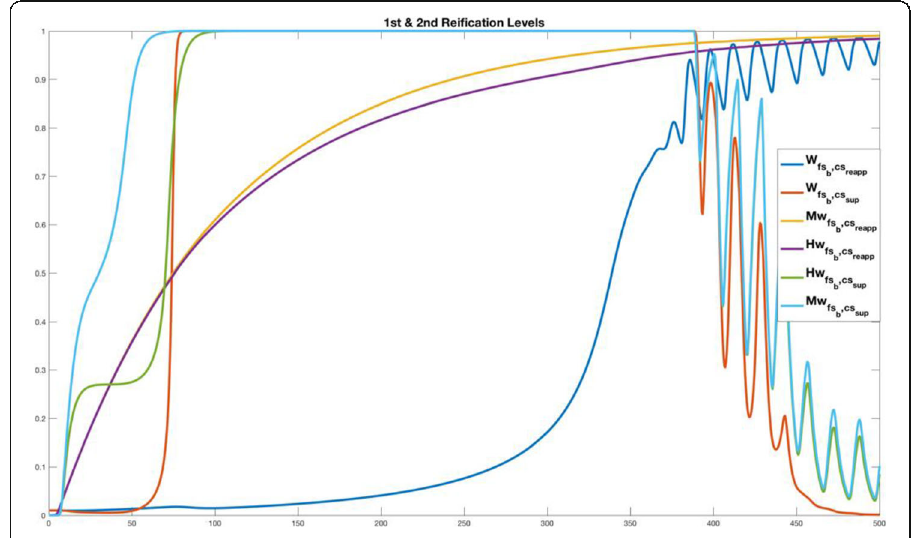
Fig. 5 First- and second-order adaptation states over time